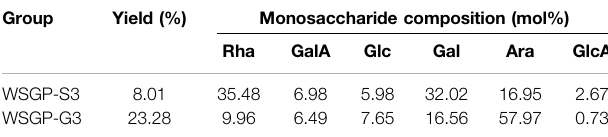
TABLE 1 | Yield and monosaccharide analysis of WSGP-S3 and WSGP-G3. Group Yield (%) Monosaccharide composition (mol%) Rha GalA Glc Gal